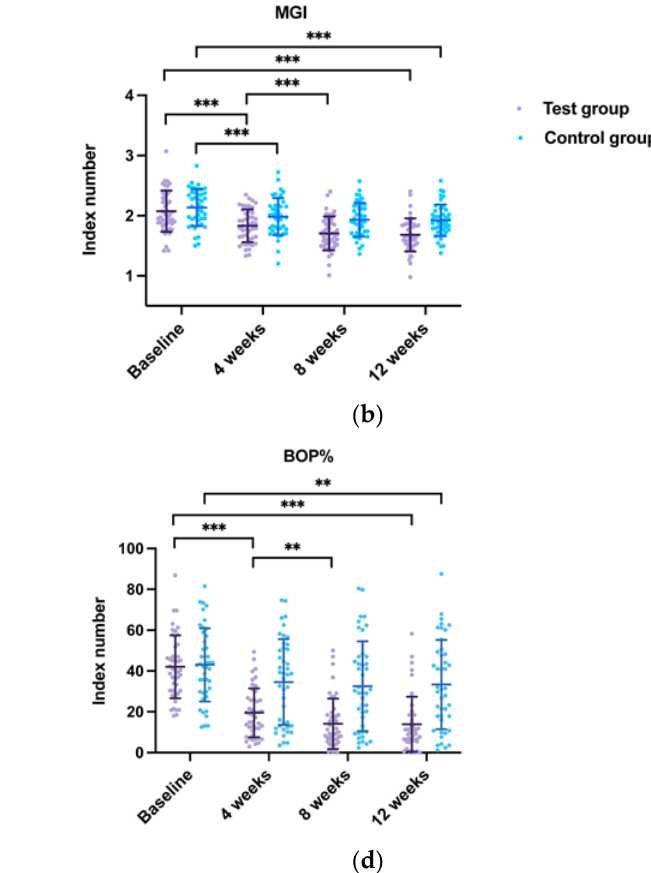
Figure 3. Scatter diagram of periodontal indices for two groups at follow-up (full analysis set). ( a ) T-QH, Turesky-Modified Quigley-Hein Plaque Index; ( b ) MGI, Modified Gingival Index; ( c ) BI, Bleeding Index; ( d ) BOP%, percentage of sites with bleeding on probing. Intragroup comparisons in ( a , b ) were performed using two-way repeated measures ANOVA and post hoc tests with Bonferroni correction. Intragroup comparisons in ( c , d ) were performed using Friedman’s test (** p < 0.01, *** p < 0.001).